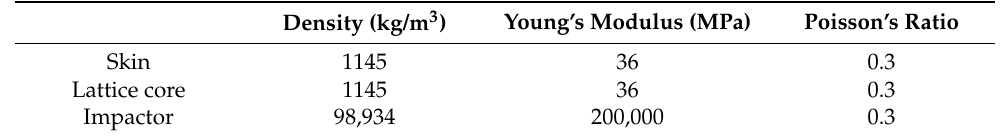
Figure 3. ( a ) The structure of 3D finite element model, and ( b ) a quarter-symmetry model for this analysis. Table 2. The physical properties of the sandwich structures and impactor.